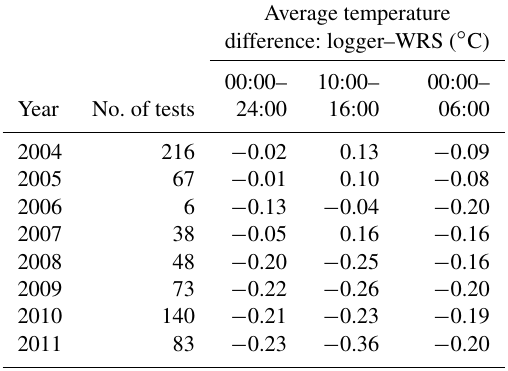
Table 2. Test result statistics by year showing the total number of tests performed, the average difference between the hourly logger and WRS temperatures for all hours 00:00 to 24:00MST,